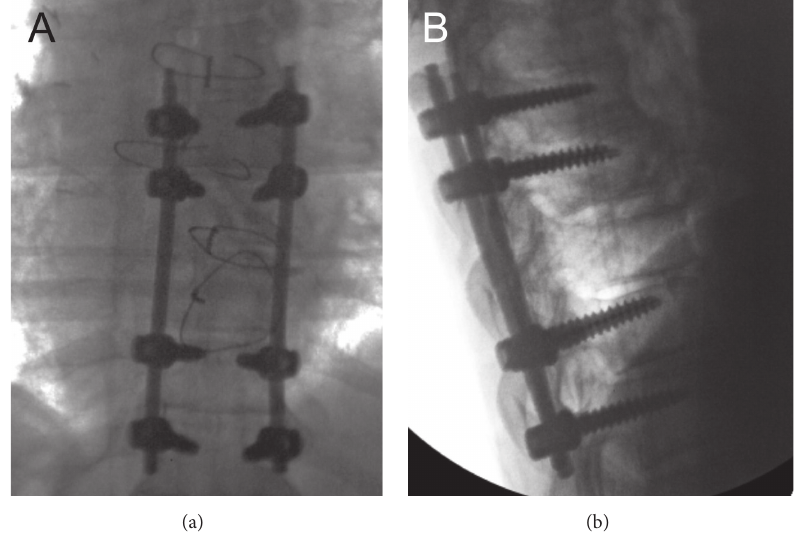
Figure 5: Intraoperative fluoroscopic images ((a) anteroposterior; (b) lateral) showing optimal positioning of the spinal fixation hardware as well as good alignment of the thoracic